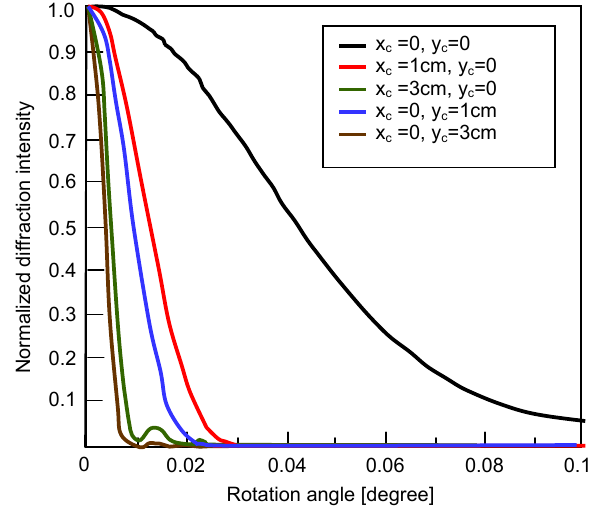
Figure 5. Rotational sensitivity of the volume hologram with random phase